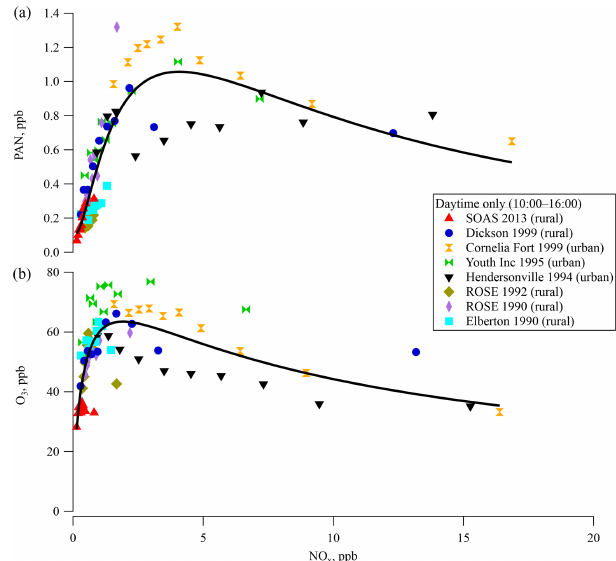
Figure 3. Surface (a) PAN and (b) ozone concentrations for each ground site in the southeastern US over the last 23 years for 10:00– 16:00 as a function of the concentration of NO x in deciles. The solid line indicates a fit line for all